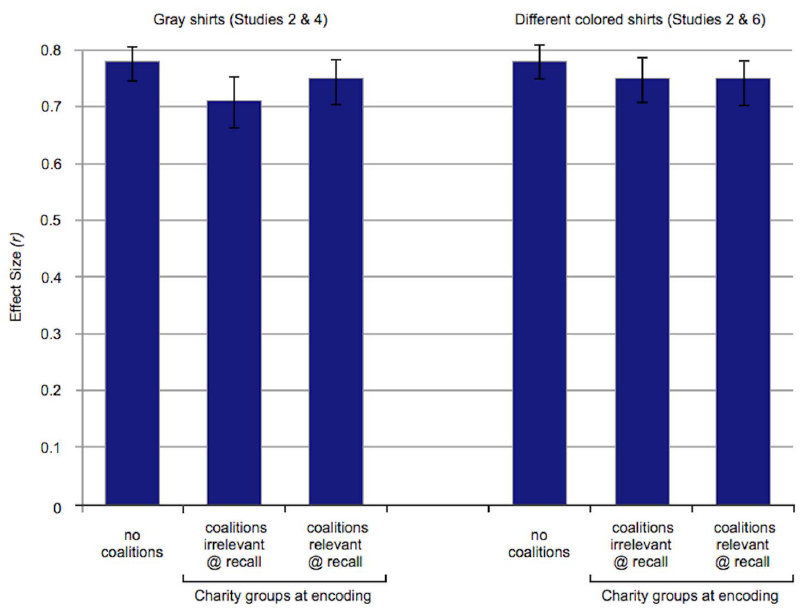
Figure 3. Gender categorization does not respond to coalitional variables (Studies 2, 4, and 6). The left panel depicts effect sizes for gender categorization when all targets were wearing gray shirts. The right panel depicts effect sizes for gender categorization when gender was crossed with shirt color. In each panel, the leftmost bar (labeled ‘‘no coalitions’’) depicts gender categorization when coalitions were absent (Study 2). The two bars to its right depict gender categorization when coalitions were present and crossed with sex (Study 4: gray shirts; Study 6: different colored shirts). Gender was retrieved at the same high levels no matter how strong the coalitional cues; there were no significant differences between conditions. Error bars: + / 2 1 S.E.